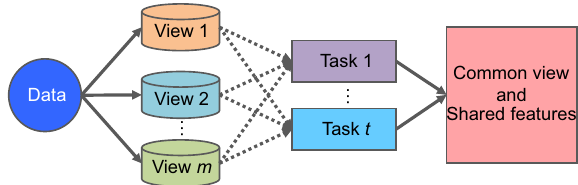
Fig. 12 General procedure of multi-task multi-view clustering.